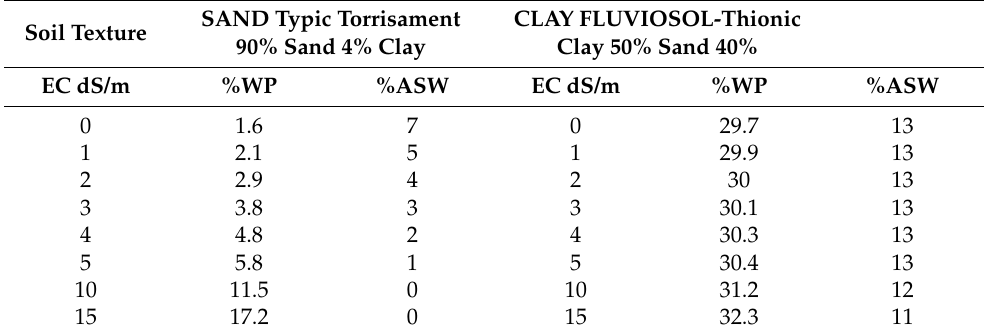
Table 3. SPAW calculations of percent volumetric soil water content at wilting point (WP) and available soil water (ASW) as a function of increased arbitrarily electrical conductivity (EC) for sand and